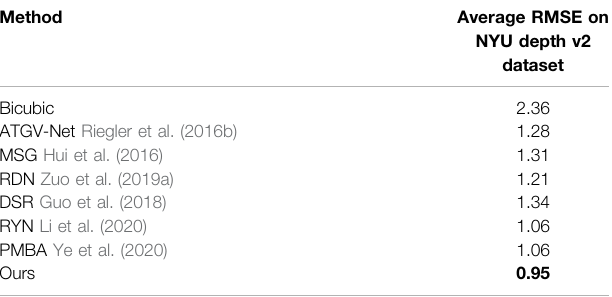
TABLE 5 | Quantitative comparisons on the NYU depth v2 dataset in terms of average RMSE values for a scaling factor of 4.